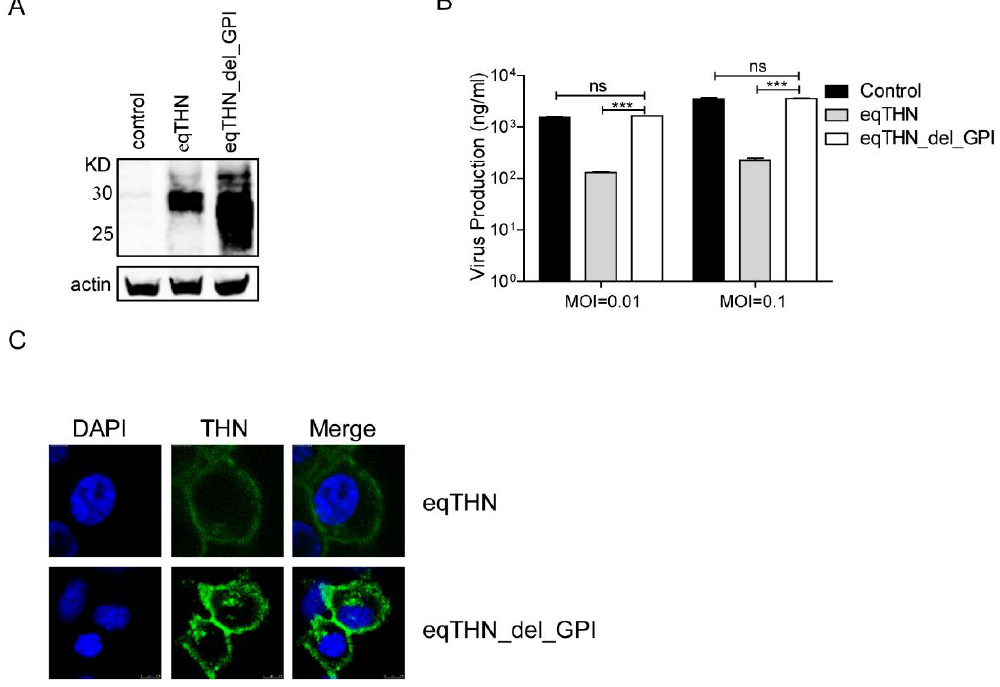
Figure 3. The GPI anchor was the key domain for the tethering function of eqTHN. ( A ) Stable expression of HA-tagged eqTHN_del_GPI in MDCK cells. Cells were lysed and the sample was treated as described for panel A in Figure 1; ( B ) The amount of SC09 released from MDCK and eqTHN_del_GPI-expressing MDCK cells at 48 h post-infection with SC09 at MOIs of 0.01 and 0.1. Infection and detection were carried out as described as above. The results of a single experiment performed with duplicate samples are shown, and results were subsequently confirmed in three separate experiments. Error bars indicate standard deviations (SD); ( C ) Subcellular localization of eqTHN and eqTHN_del_GPI on the cell surface with scale bars indicating 10 µ m. Detection was carried out as described for panel F in Figure